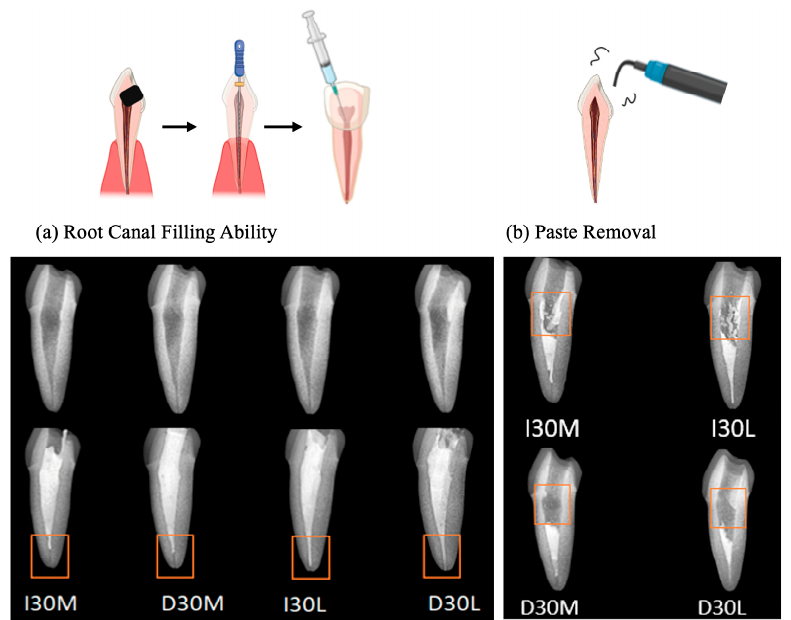
Figure 3. Usability test of NaI-based paste compared to iodoform-based paste. ( a ) Postoperative radiograph immediately after root canal treatment. ( b ) Postoperative radiograph after removing filling material using an ultrasonic scaler.